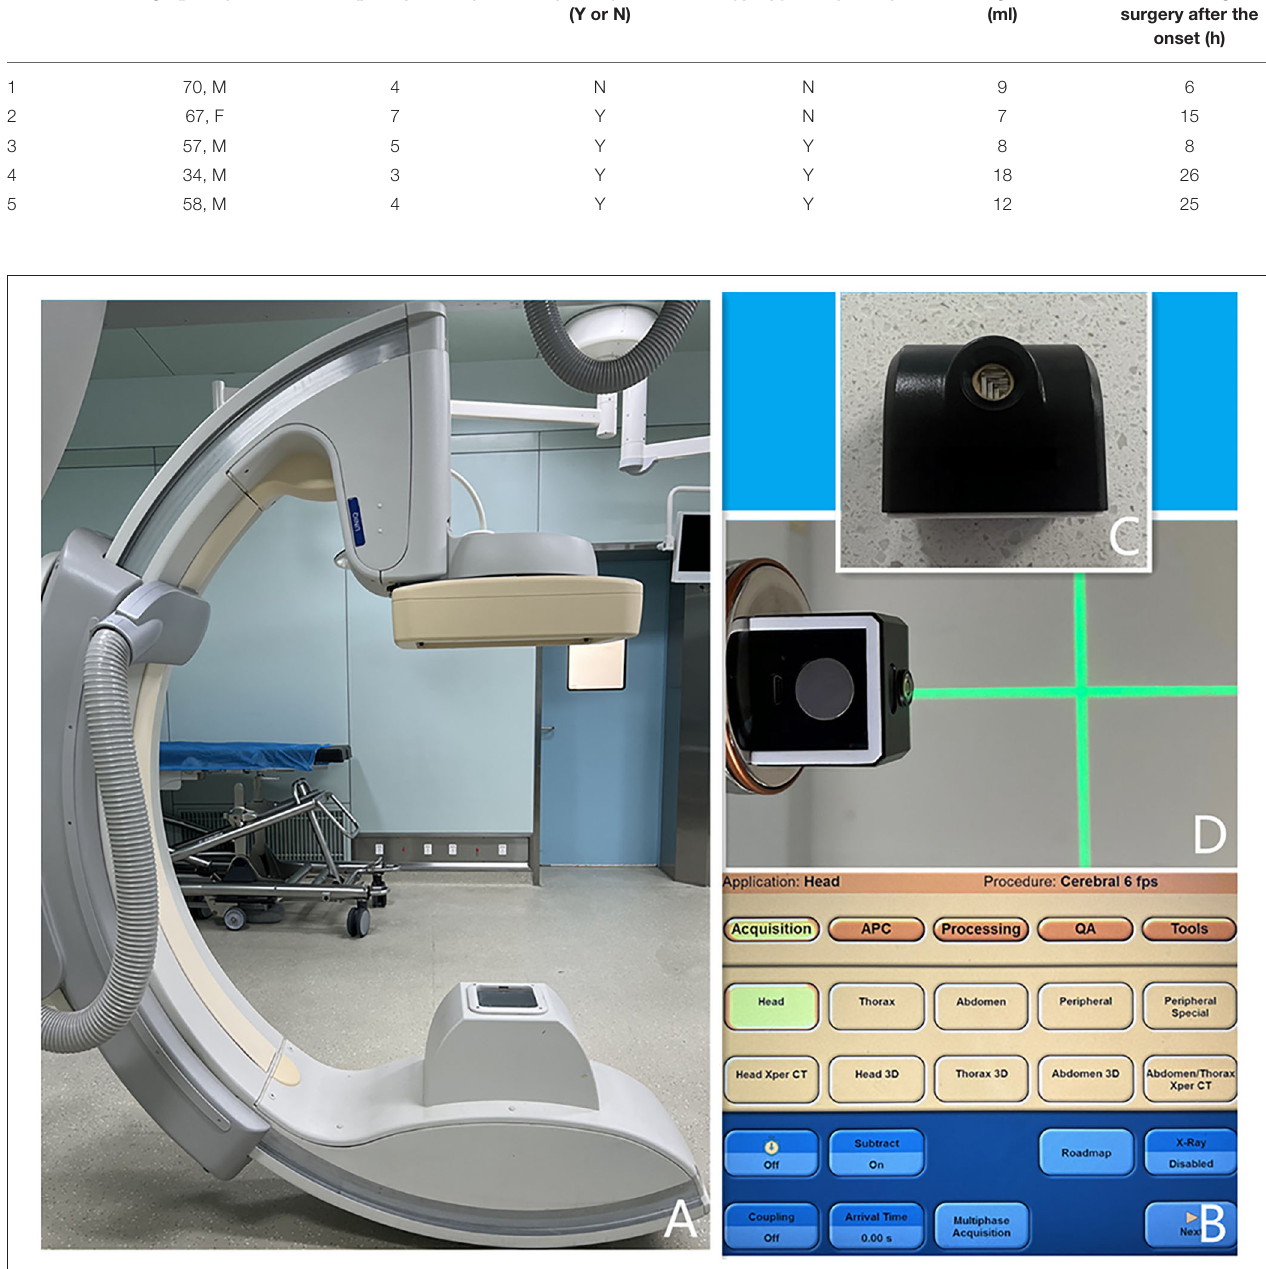
was passed through the percutaneous puncture point while ensuring the crossing of the laser ( Figures 3C,D ). The point always pointed to the center of the external end of the puncture needle ( Figure 3E ), and the drainage tube was slowly advanced and pushed into place according to the pre-measured puncture